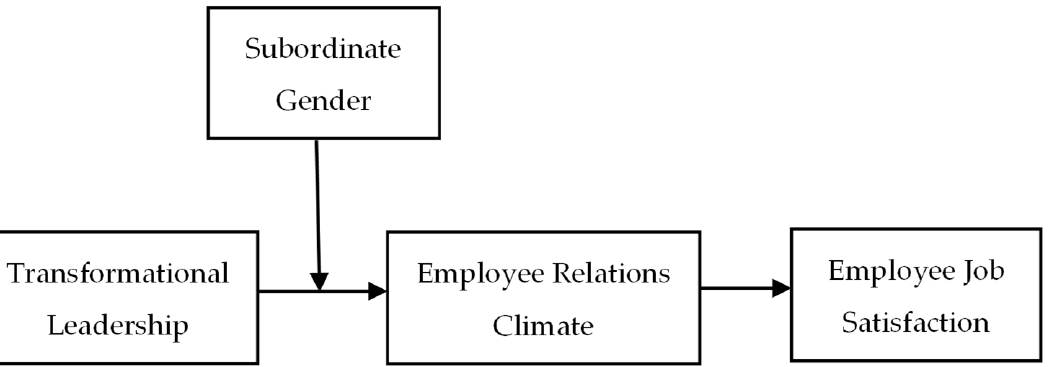
Figure 1. The conceptual model of the relationship between transformational leadership, employee relations climate, subordinate gender, and employee job satisfaction.